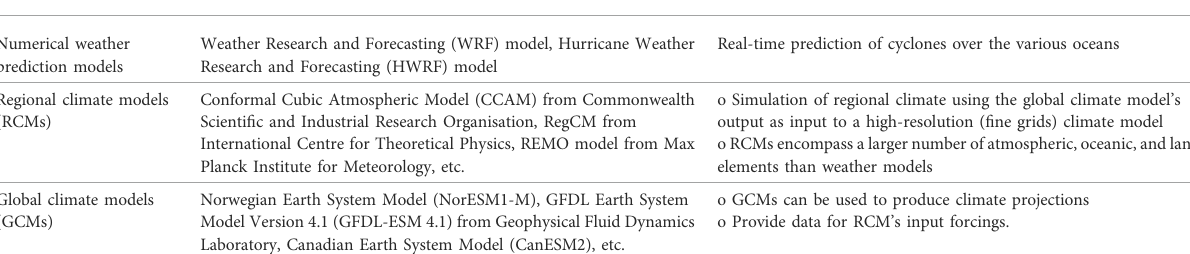
TABLE 2 Details on the weather and climate models in